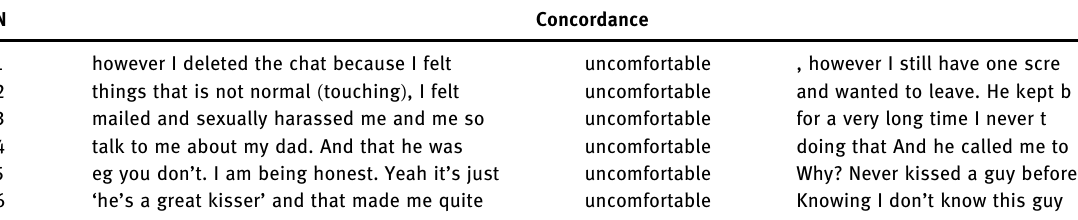
Table 24: Concordance lines for uncomfortable